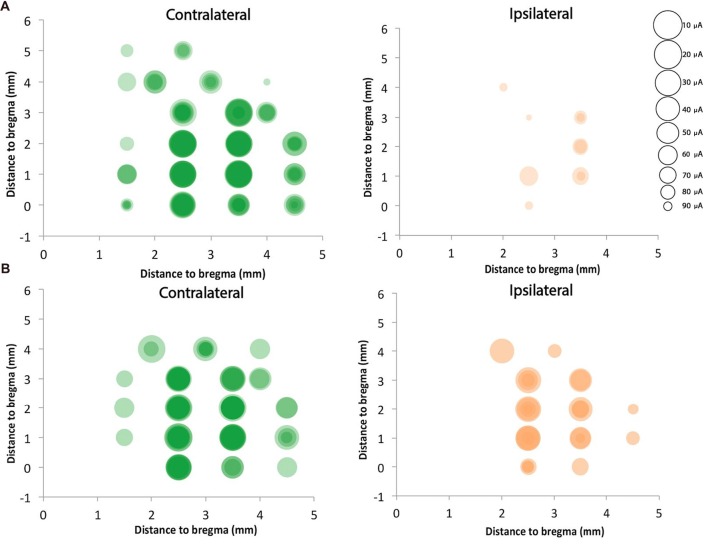
Strong ipsilateral representation after neonatal pyramidotomy. ICMS was performed on four control rats and four rats with neonatal pyramidotomy. Twenty-three sites were mapped in the right cortex, which was in the uninjured hemisphere of rats with neonatal pyramidotomy. Responses from both forelimbs (contralateral and ipsilateral) were recorded. The sizes of the circles were inversely proportional to the threshold for provoking a movement, as indicated in the scale at right. Responses in individual rats were shaded a light color, and the darkness of the circles indicated how many rats of the four rats had responses at each site. In control rats (A), the responses were mainly on the contralateral forelimb. However, in the rats with neonatal pyramidotomy (B), stronger responses were noted in the ipsilateral forelimb in comparison to that of the control rats. In contrast, the responses from the contralateral forelimb of the rats with neonatal pyramidotomy were less robust than that of the control rats.